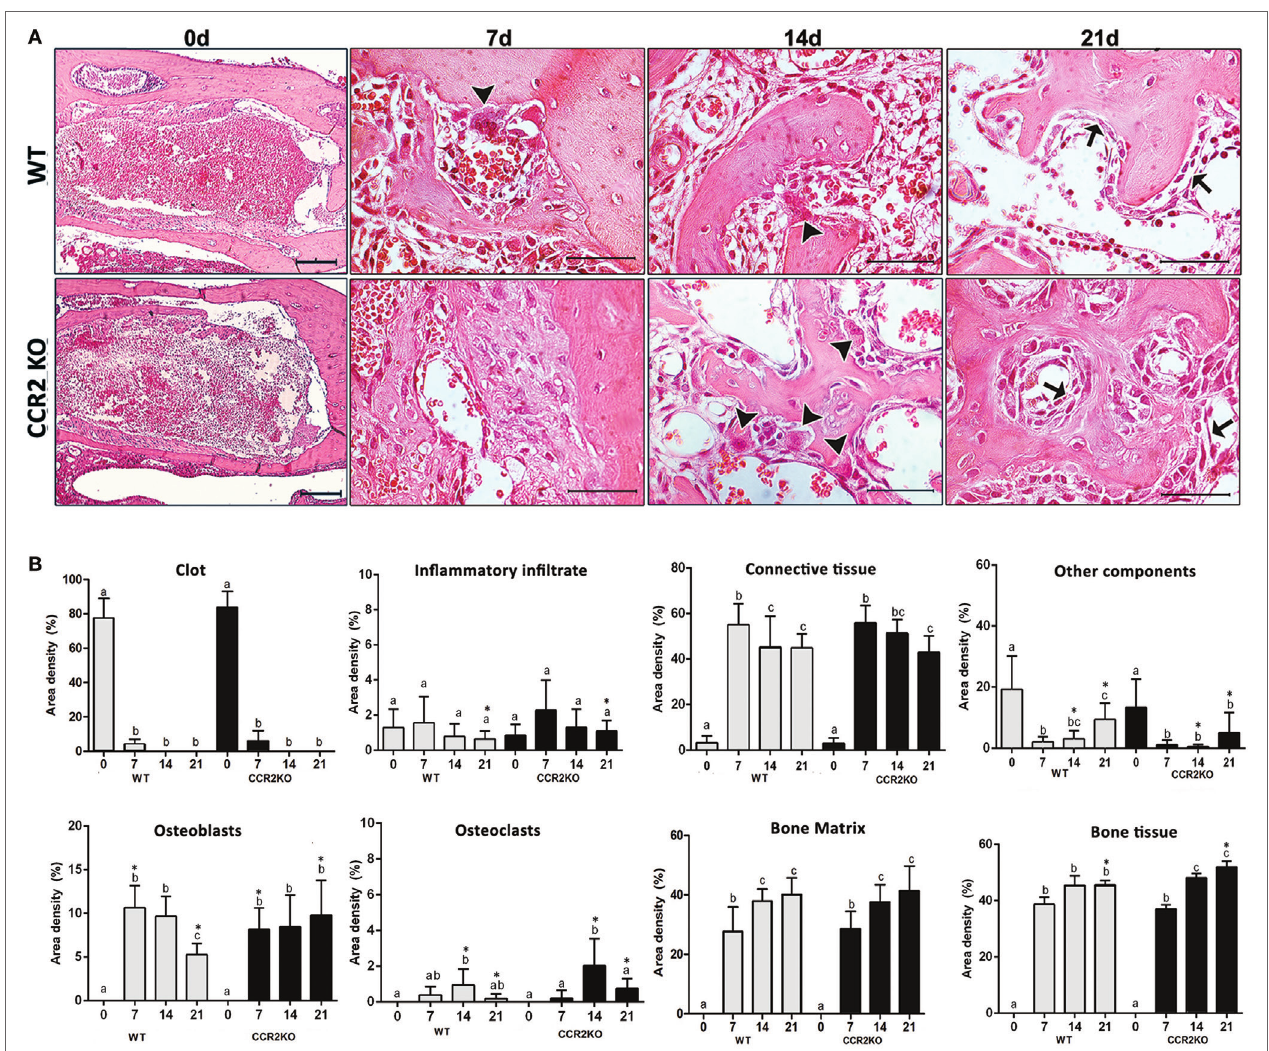
FigUre 3 | Histological and histomorfometric analysis of healing components during the intramembranous bone healing in wild-type (WT) vs CCR2KO mice. (a) Comparative morphology of the healing phases at 0 h, 7, 14, and 21 days post-extraction of upper right incisor, stained with H&E (0 h—10 × magnification and bar = 200 µm; 7, 14, and 21 days—40 × magnification and bar = 100 µm). (B) Results are presented as the mean of area density for each structure measured in each examined group. Different letters indicate significant differences in each time point ( p < 0.05); symbol * indicates significant differences between WT vs CCR2KO at the same time point (arrowheads = osteoclasts; arrows =